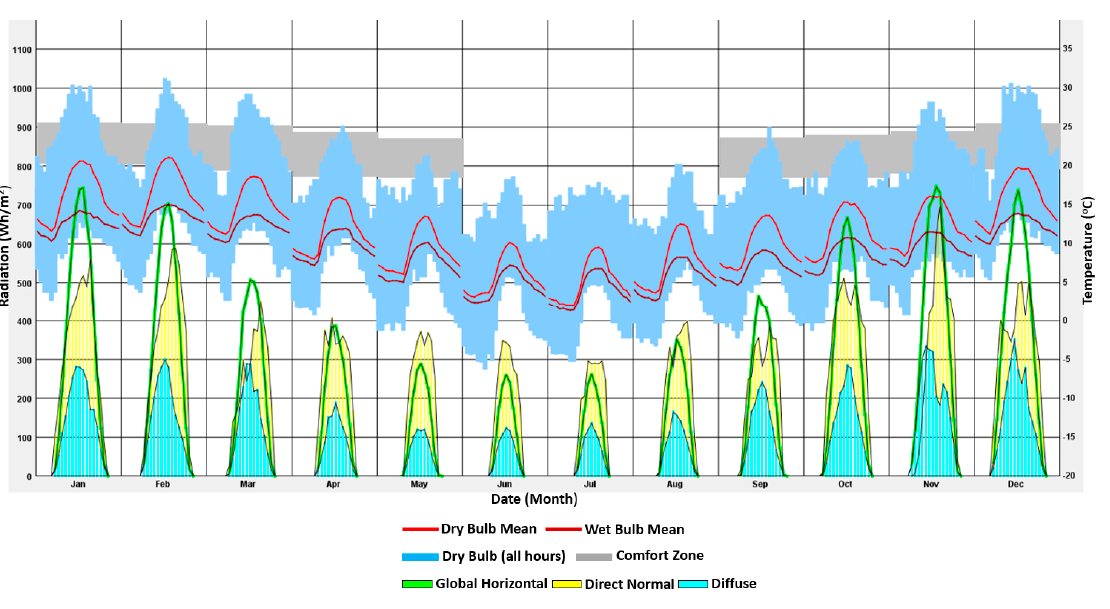
Table A3. Building materials for external door construction.